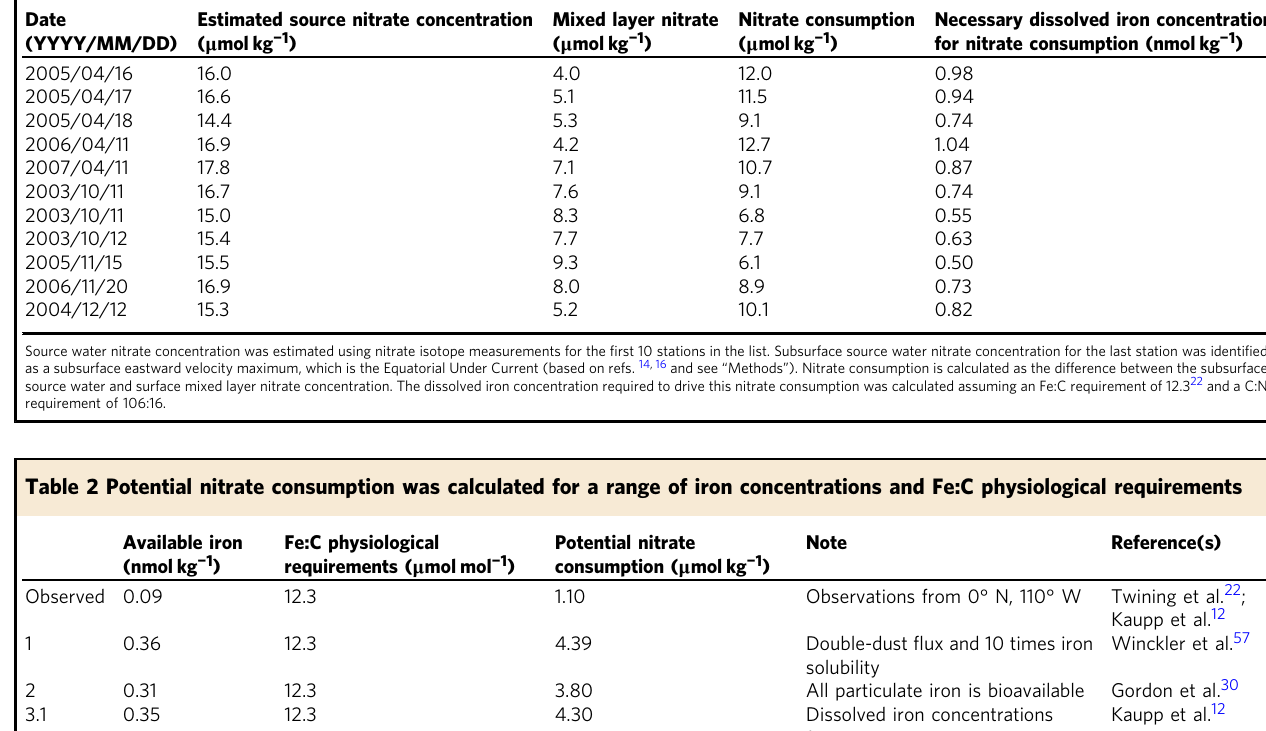
Table 1 Data and calculations for all station